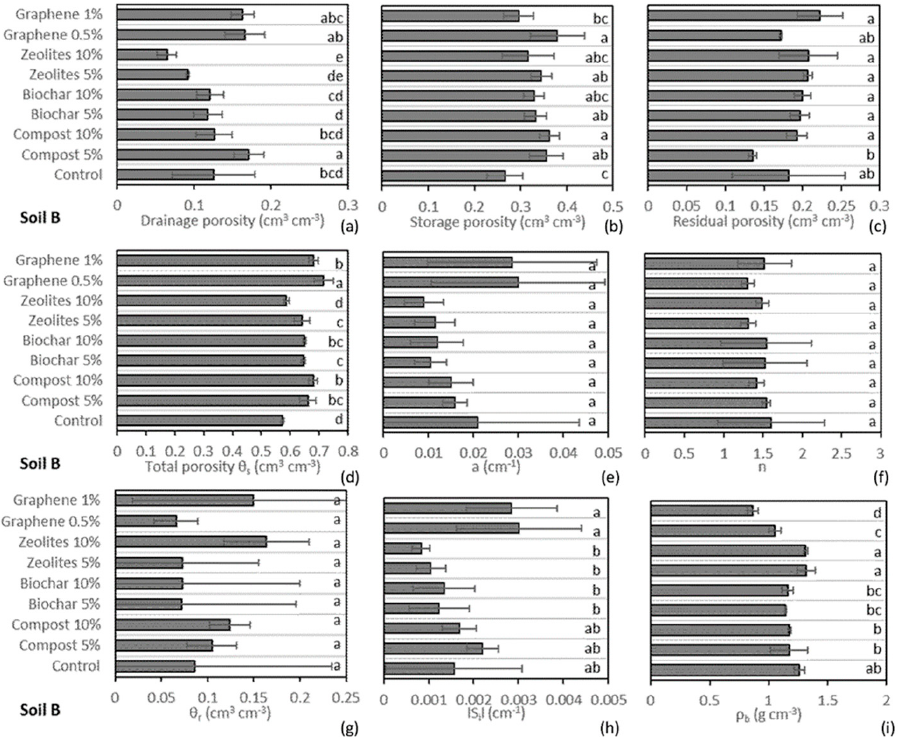
Figure 6. Mean ± st. dev. of drainage ( a ), storage ( b ), residual ( c ), and total (measured θ s ) porosities ( d ), fitted van Genuchten parameters ( e – h ), and ρ b ( i ) with the statistical LSD comparison between treatments for each parameter of Soil B. The same letter indicates no statistical differences among